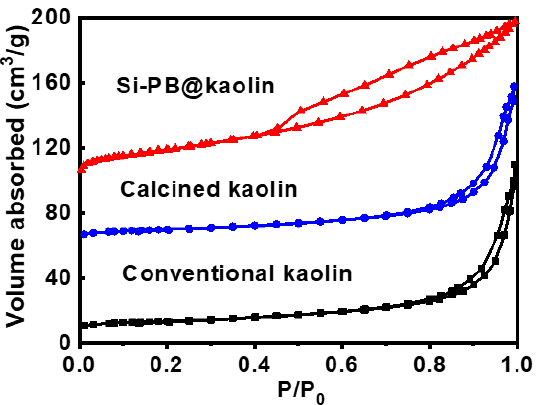
Figure 2. N 2 adsorption–desorption isotherms for conventional kaolin, calcined kaolin and Si-PB@kaolin composite.